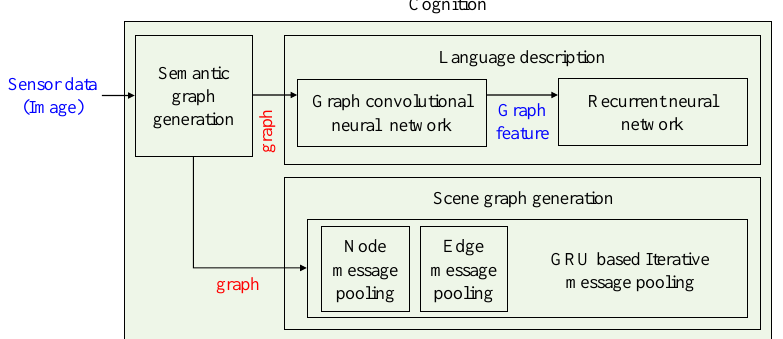
Figure 3. On language description part, a GCN extracts features from the graph map. The extracted graph feature is concatenated with a word and feed into the RNN as input. Then, the RNN generates sentence attention over the graph. On scene graph generation part, Two different message pooling methods are performed. Node message pooling uses the inbound and outbound edge states with a node. Edge message pooling uses the object states with an edge. This process is repeated to precisely predict the natural language words corresponding to the nodes and edges of the